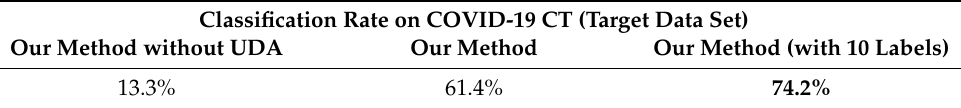
Figure 5. Random samples of prediction from the Identification module on the target data set (COVID-19 CT), showing satisfactory results even when the spine is not well aligned on the coronal and sagittal axis. Table 2. Classification rate on the COVID19-CT data set for the three trained models with the best classification rate in bold. The effectiveness of un- and semi-supervised domain adaptation is